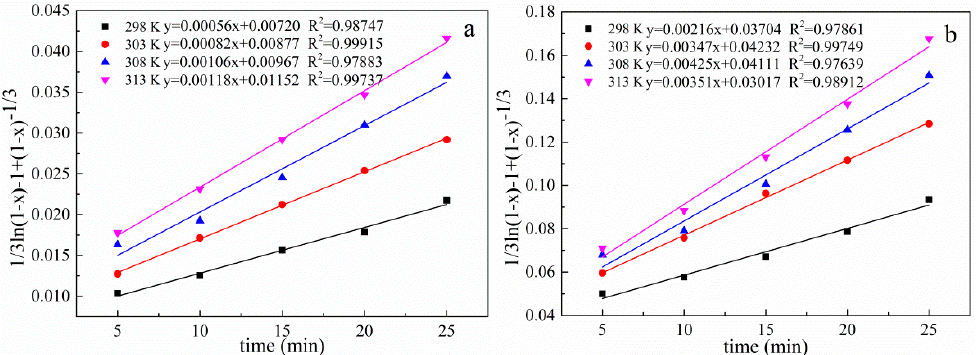
Figure 20. Plot of 1/3ln(1 − x) − 1 + (1 − x) − 1/3 versus time for different temperatures under conventional and ultrasonic conditions. ( a ): under conventional conditions; ( b ): under ultrasonic conditions. Table 2. Correlation coefficient of diffusion control and interface chemical reaction control at different temperatures under conventional conditions.